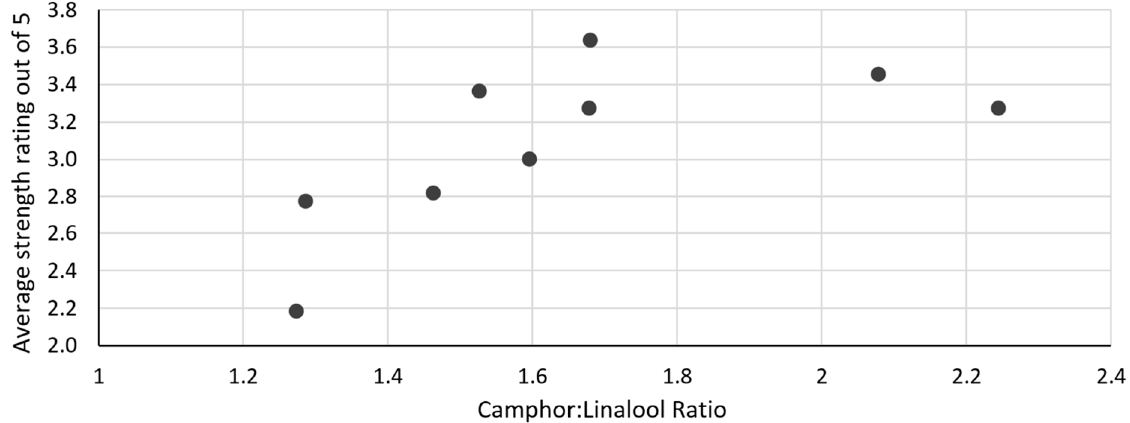
Figure 2. Smell strength of lavender oil samples versus their camphor-to-linalool ratios.